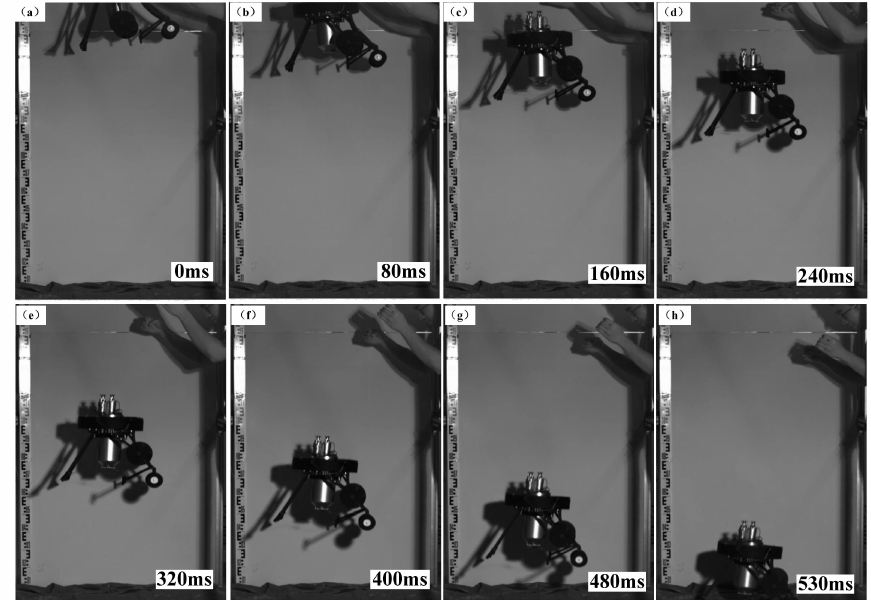
Figure 9. The time sequence of aerial pitch control experiment No. 4, Group 1.